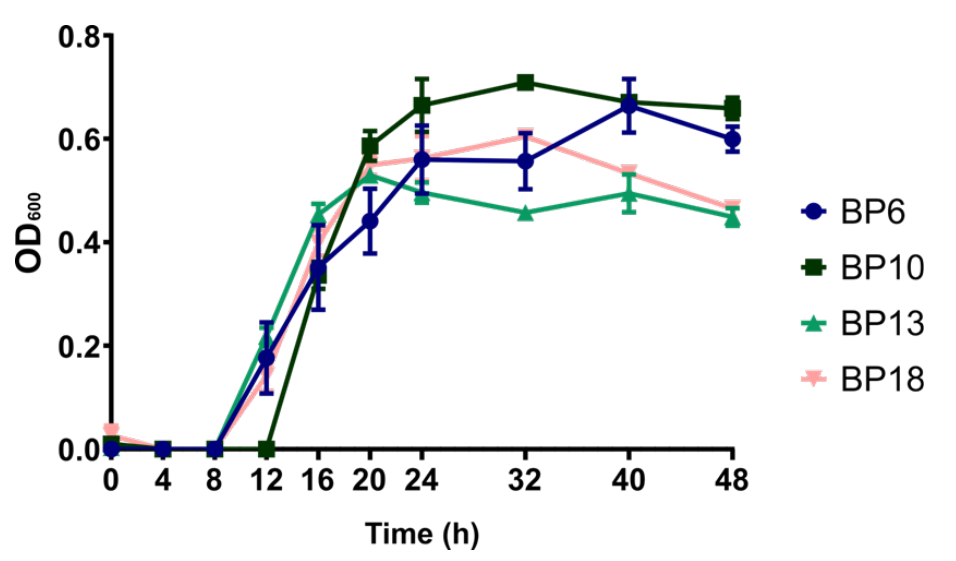
Figure 1. Growth profiles of the four selected B. pumilus strains. OD 600 = optical density measured at 600 nm. Bars indicate standard error of mean.